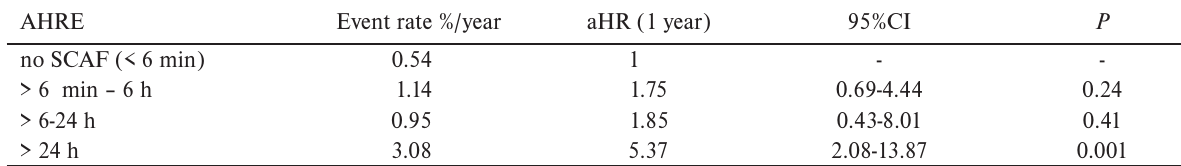
Table 3. Risk of stroke in ASSERT trial according to AHRE duration 32